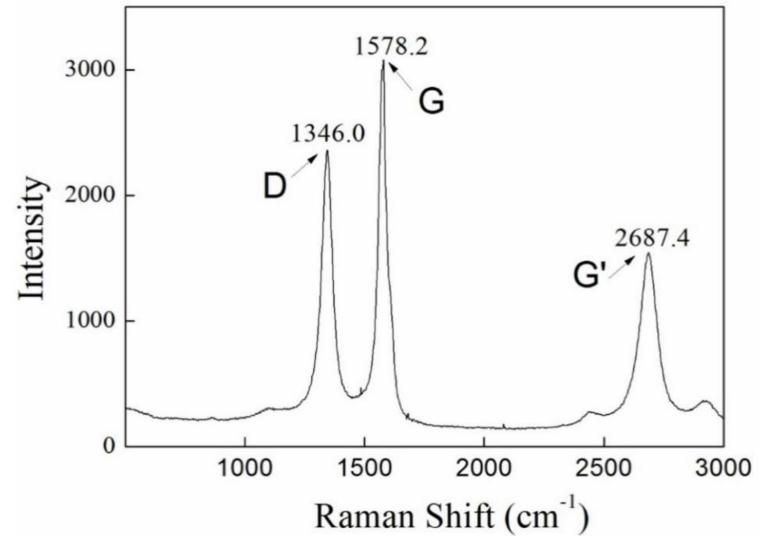
Figure 4. Raman spectrum of the as-fabricated mullite-CNT composite membrane.